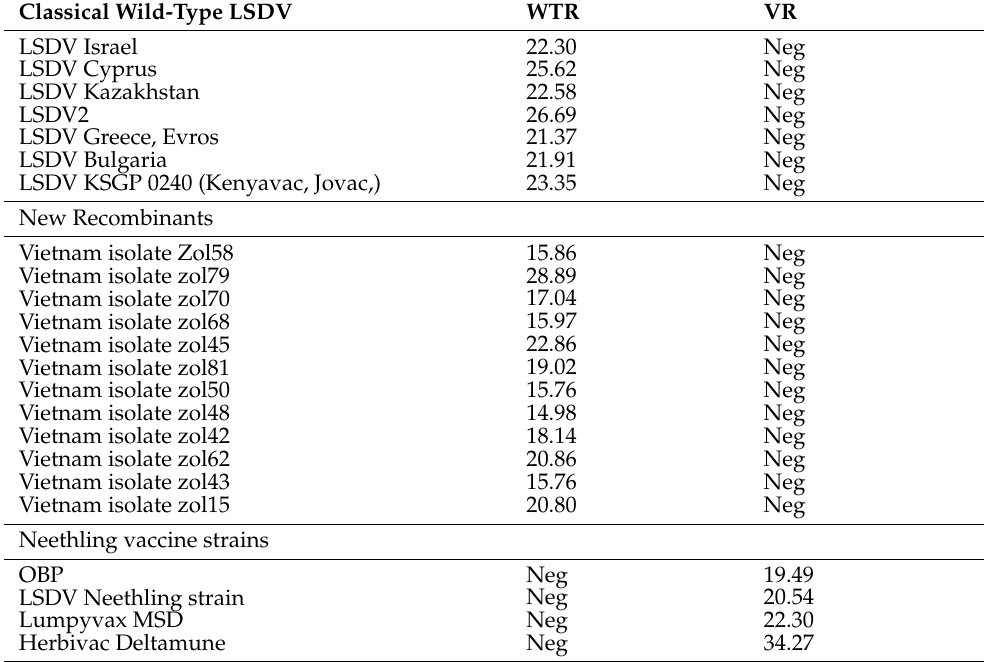
Table 2. Real-time PCR results for a range of classical wild-type, recombinant type, and Neethling vaccine strains (WTR: wild-type reaction; VR: Neethling vaccine type reaction). The results are expressed as Ct values.